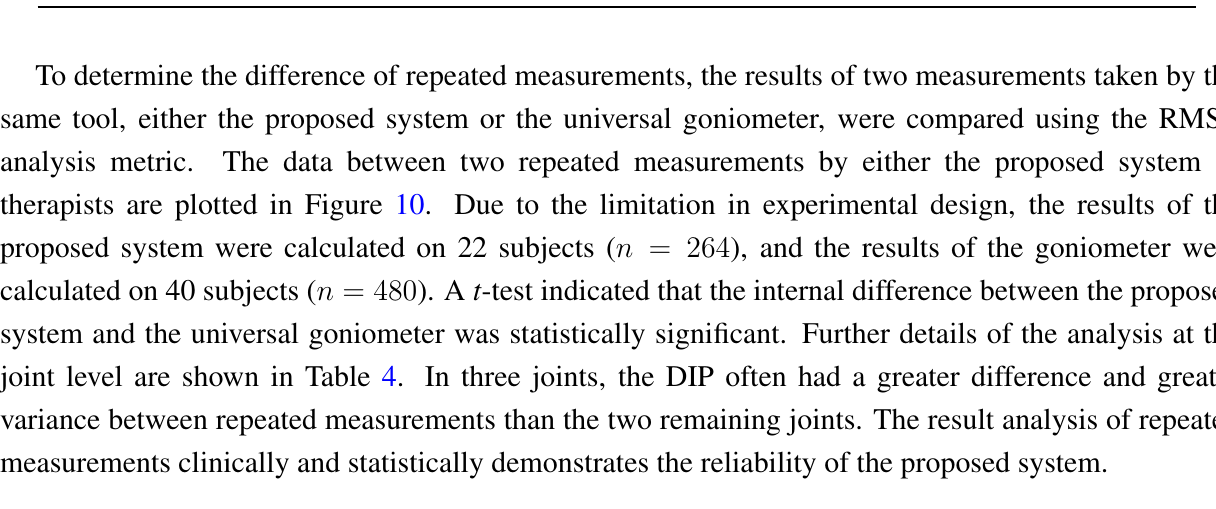
Table 4. Comparison of the consistency of the proposed system and the universal